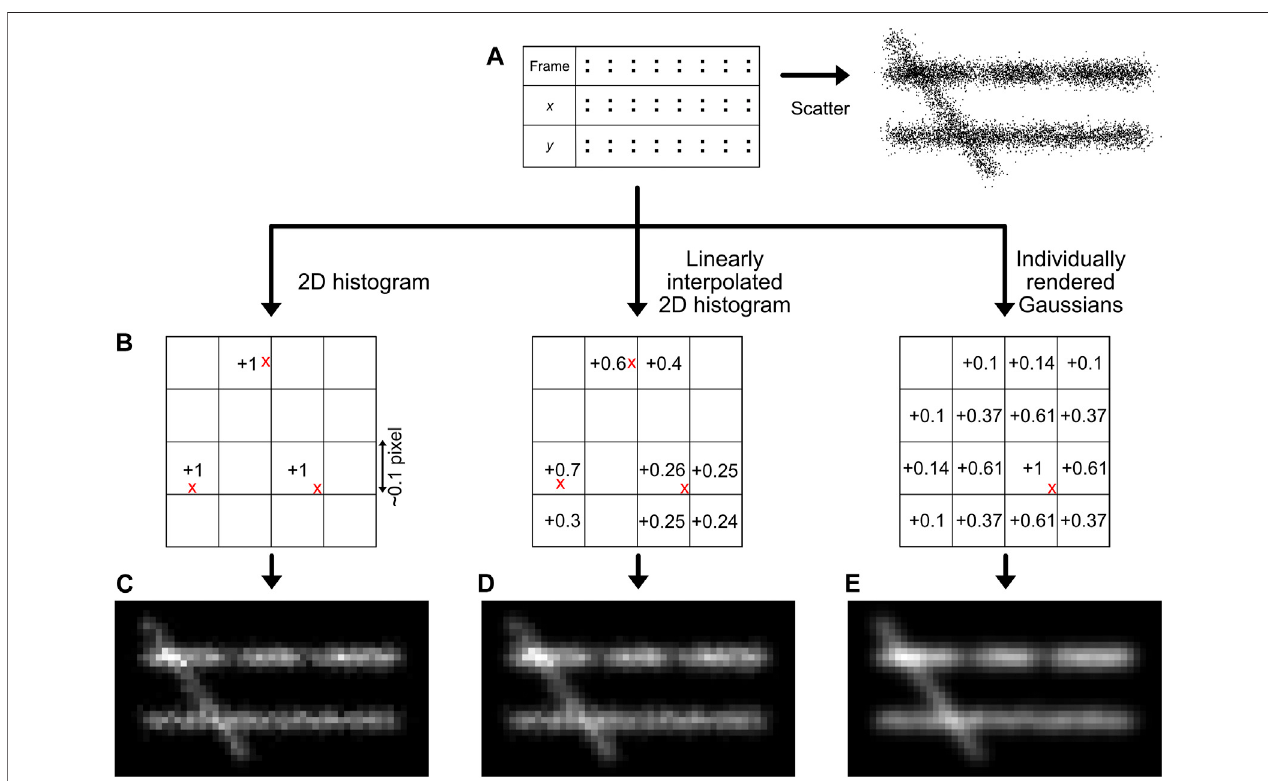
FIGURE6| Imagegenerationmethods.Thesimplestwayforimagegenerationisascatterplot,althoughthisdoesnotre fl ectthelocalizationdensityaccurately (A) . Thelocalizations(redcrosses)canalsobeplacedonasub-pixelgrid (B) ,andthebinintensitiescanbeincreasedbasedonthepositionofthelocalizations.Themethods describedinthismanuscript arethecreation ofa2Dhistogram (C) ,alinearlyinterpolated2Dhistogram (D) ,orindividuallyrenderedGaussians (E) .Notetheregionswith lowerdensity(66%lowerdensitycomparedtothesurrounding)andthedifferentintensitybetweenthetwohorizontallines(30%lowerdensity)thataremoreclearly interpreted by histogram images compared to a scatter